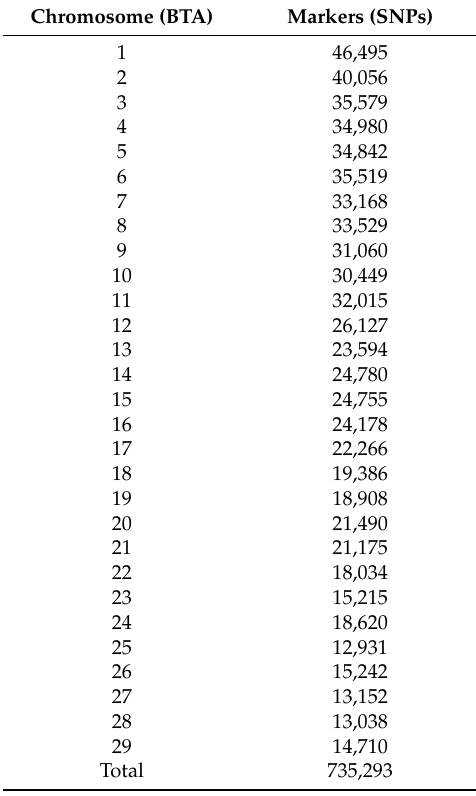
Table 1. Number of markers per